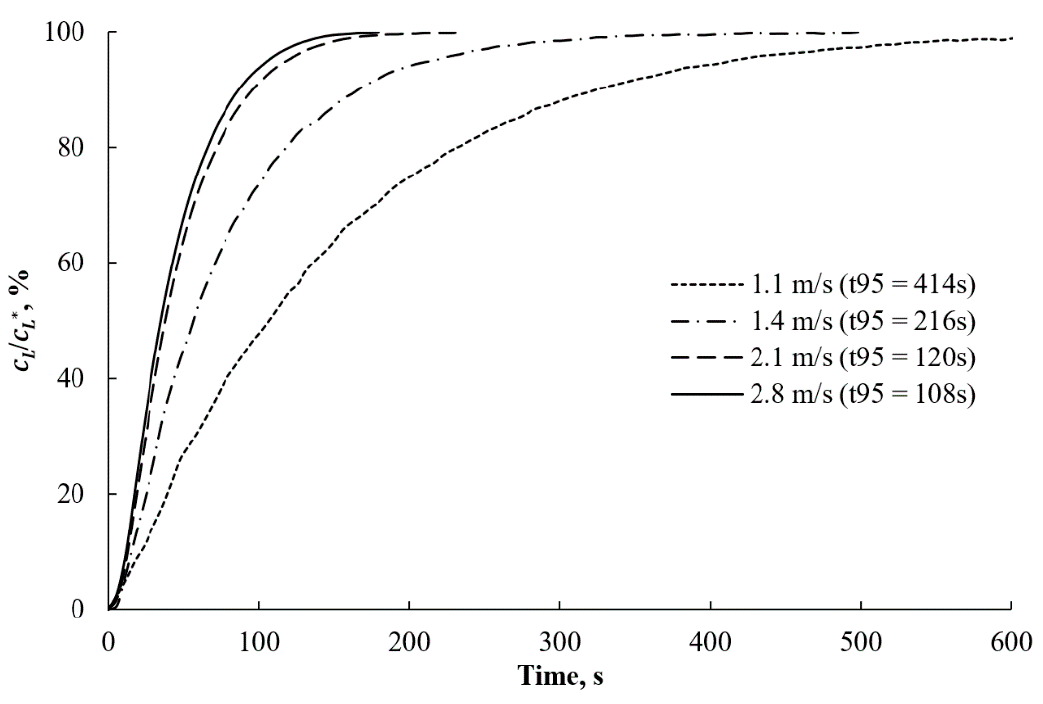
Figure 14. Oxygen transfer rates in the aerated water flow at di ff erent stream velocities in the CLR. t 95 denotes the saturation time when c L / c ∗ reaches 95%.